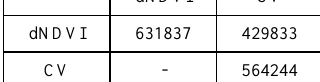
Table 16. Number of changed pixel